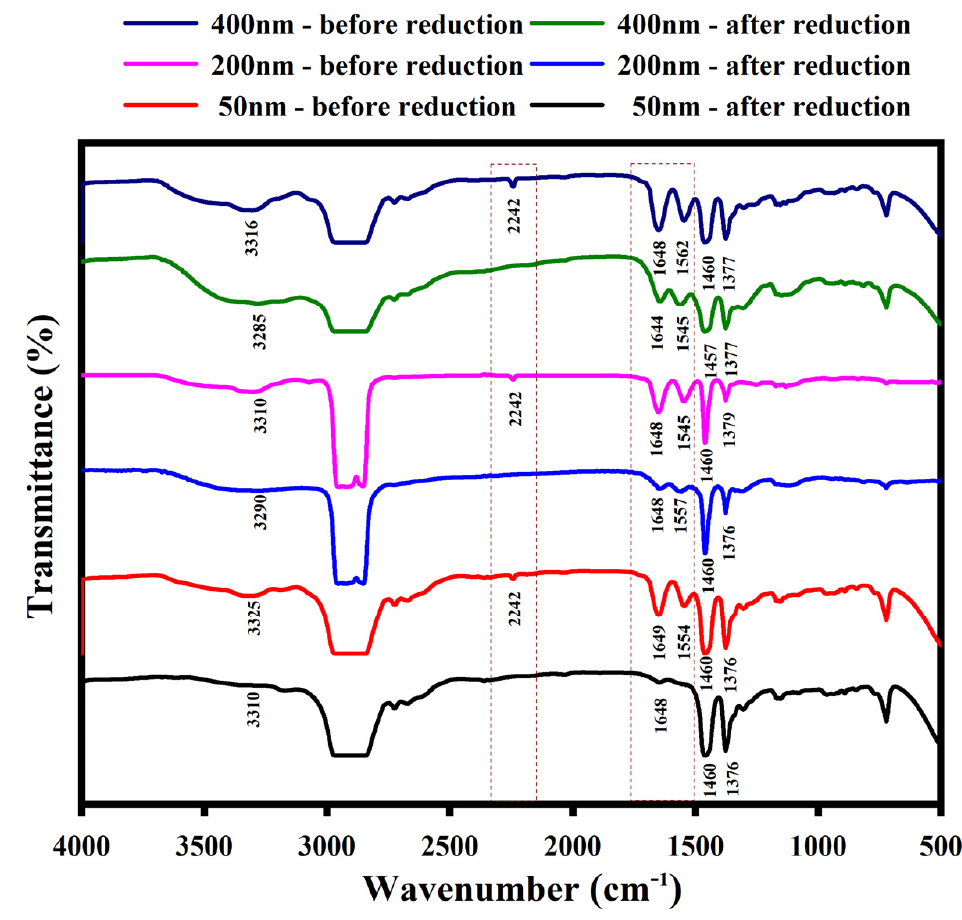
Figure 3. FTIR spectra of the NHG’s (400, 200 and 50 nm).